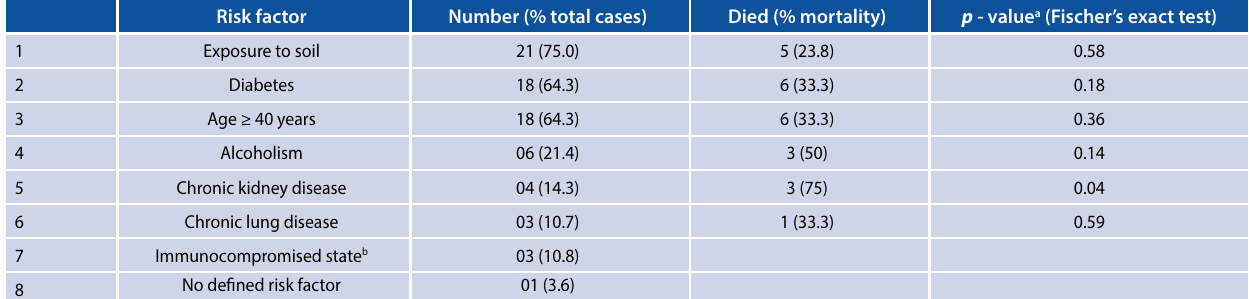
a Risk factors present versus mortality in culture positive. b One case of preterm, steroid therapy and malnutrition.